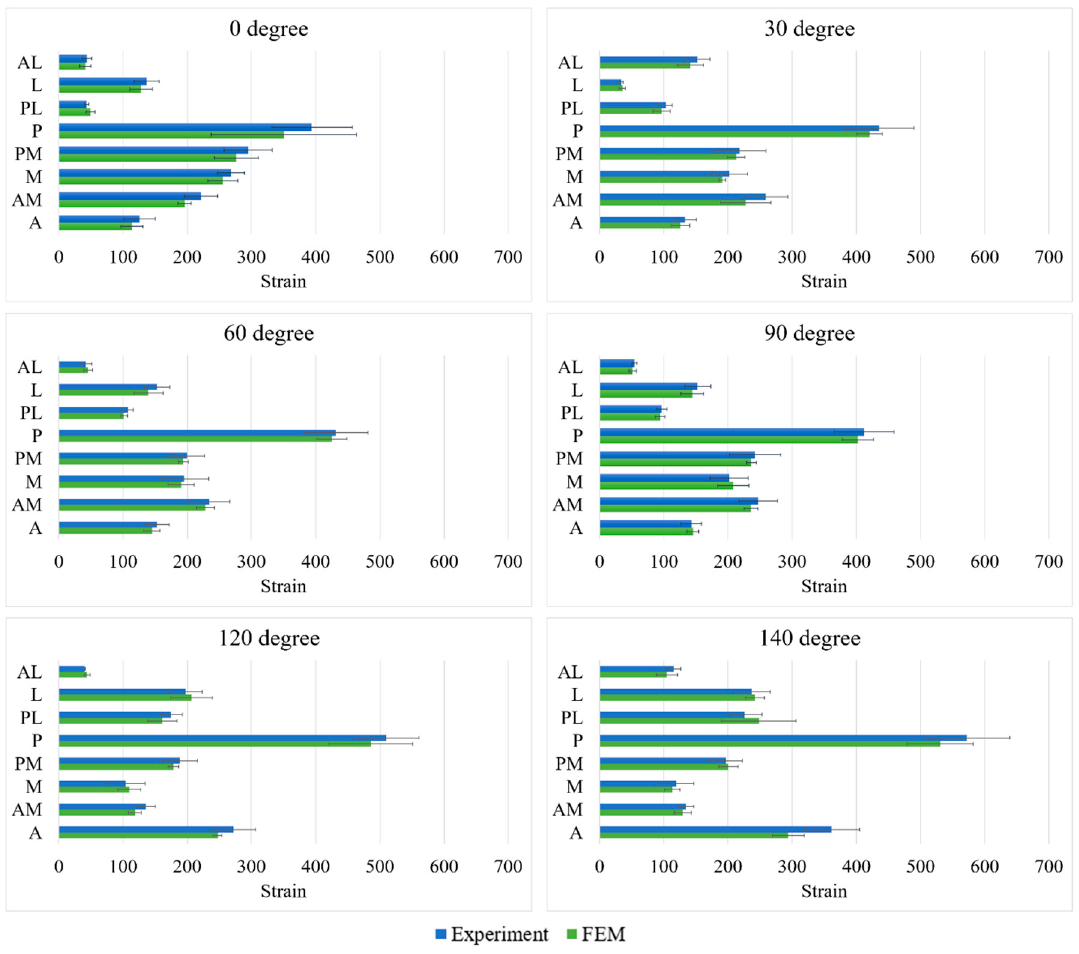
Figure 4. Results of the FE model validation (comparison of the strains from the FE models with those obtained from mechanical tests). (A, anterior; M, medial; L, lateral; P, posterior; AM, anterior-medial; AL, anterior-lateral; PM, posterior-medial; PL, posterior-lateral regions).